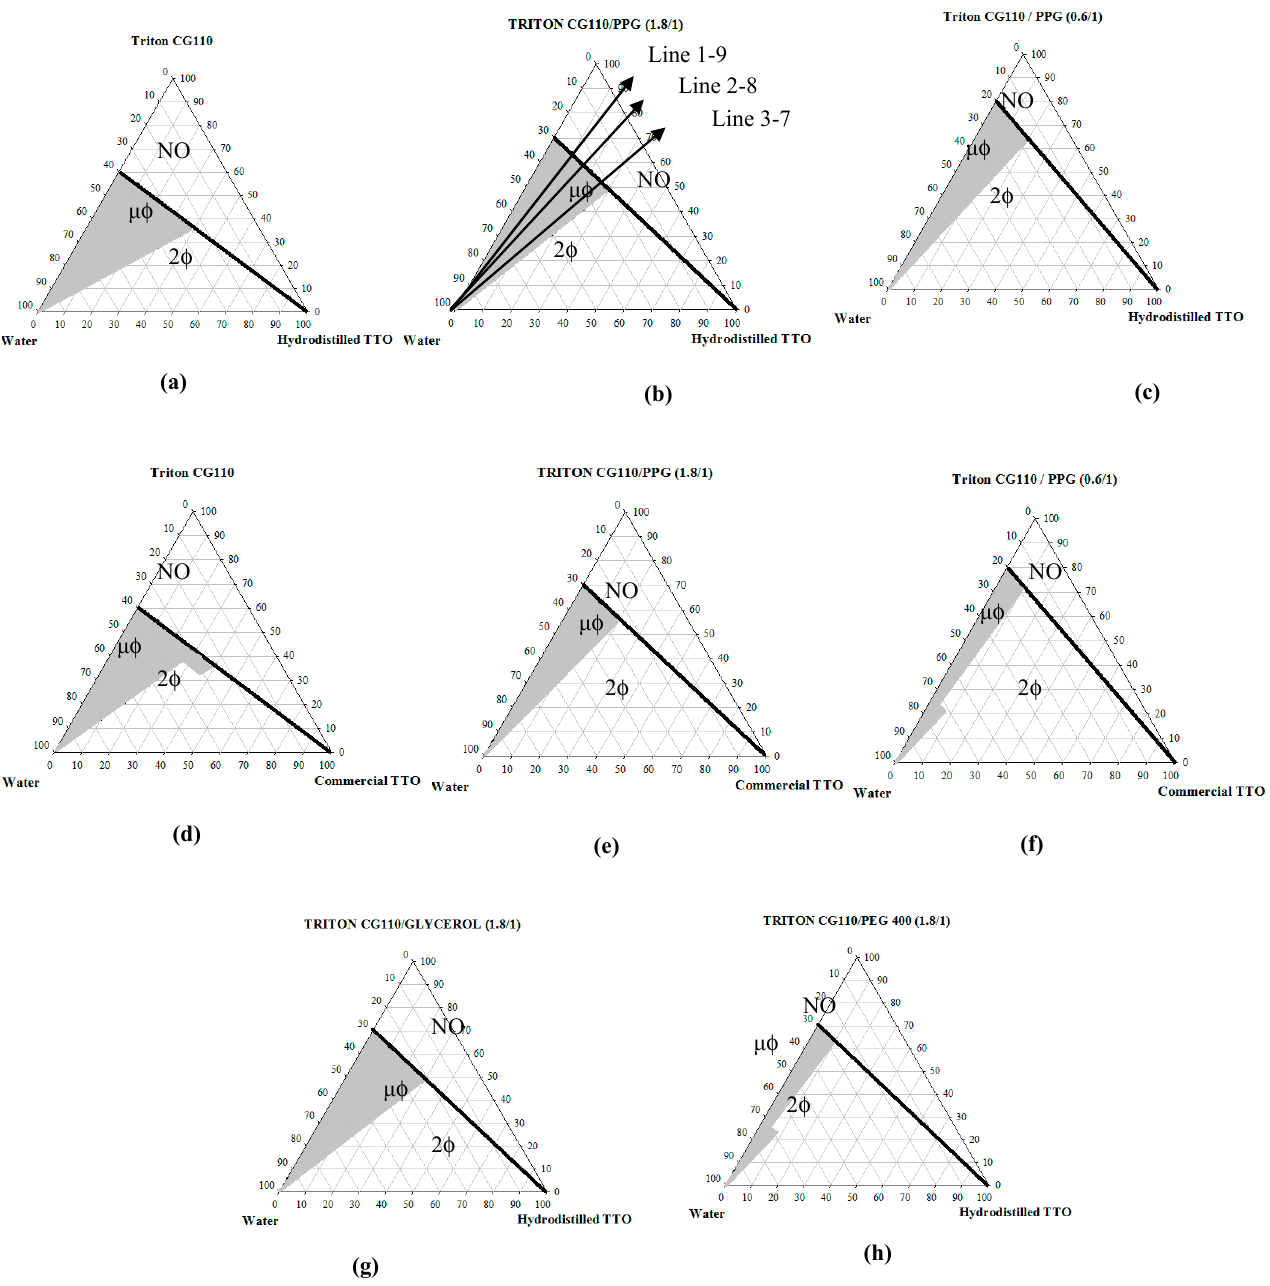
Figure 1. Pseudoternary phase diagrams of mixed surfactant—tea tree oil (TTO)—water systems. The mixed surfactants were prepared from Triton CG-110 and a co-surfactant at different mass ratios (either 0.6:1 or 1.8:1). The co-surfactants include glycerol, propylene glycol (PPG) and polyethylene glycol 400 (PEG 400), while either in-house hydrodistilled TTO or commercial TTO was used. ( a , d ) Triton CG-110 only, ( b , e ) Triton CG-110/ PPG (1.8/1), ( c , f ) Triton CG-110/PPG (0.6/1), ( g ) Triton CG-110/glycerol (1.8/1), ( h ) Triton CG-110/PEG 400 (1.8/1).